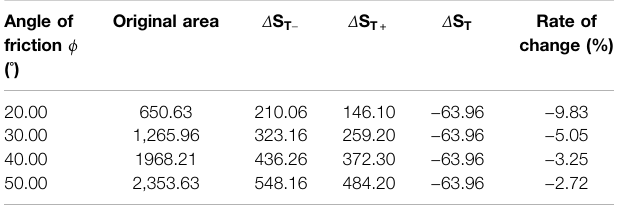
TABLE 4 | Toppling part change varies angle of friction under seismic load 0.2 g.